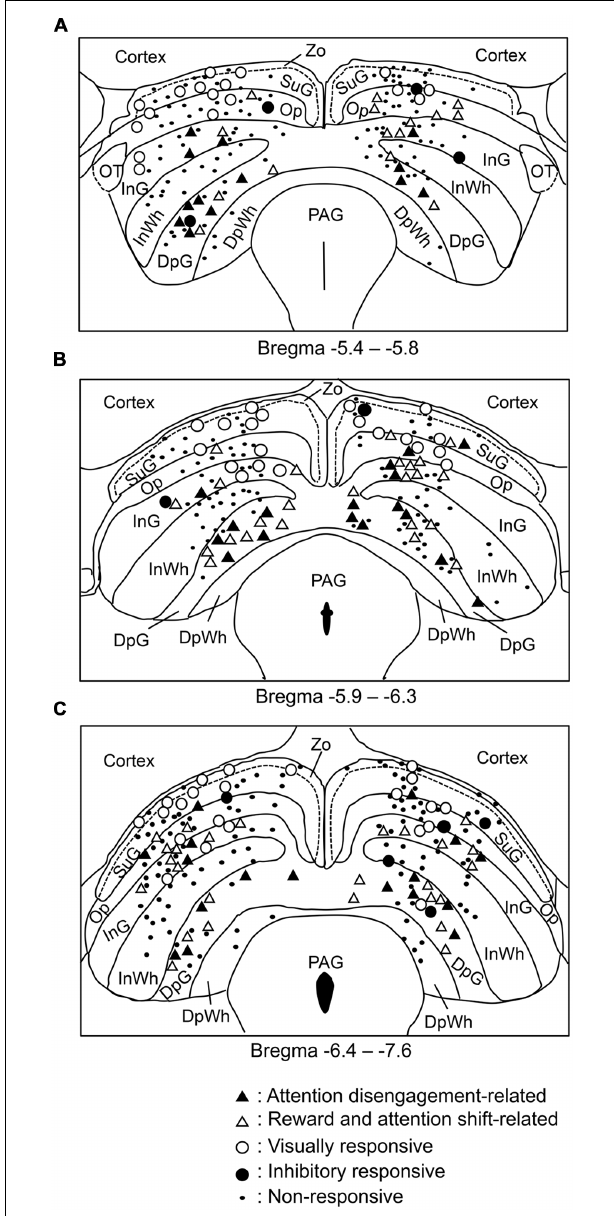
FIGURE 9 | Distributions of all neurons recorded from the SC. (A–C) Coronal sections, based on the atlas of Paxinos andWatson (2007). Values below each section indicate distance (mm) from the bregma. DpG, deep gray layer; DpWh, deep white layer; InG, intermediate gray layer; InWh, intermediate white layer; Op, optic nerve layer; PAG, periaqueductal gray; SuG, superficial gray SC; Zo, zonal layer.